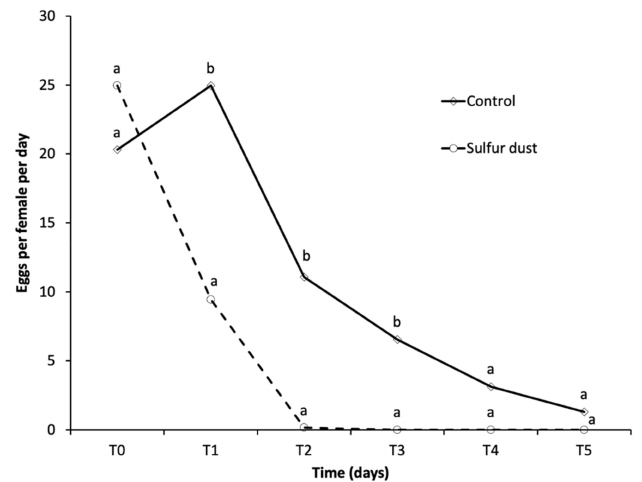
Figure 2. No-choice bioassay. Eggs laid from T1 to T5 by Lobesia botrana females on sulfur-dust-covered berries (sulfur dust) and control berries. The eggs at T0 are those laid by the same females on glass tubes the day before the beginning of the bioassay. Di ff erent small letters on the same day indicate significant di ff erences according to a two-sample t test.